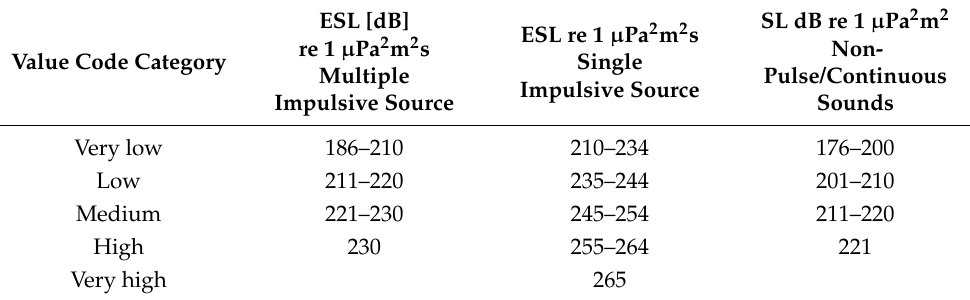
Table 1. Categorization of specific source levels (energy source level ESL (dB) re 1 µ Pa 2 m 2 s